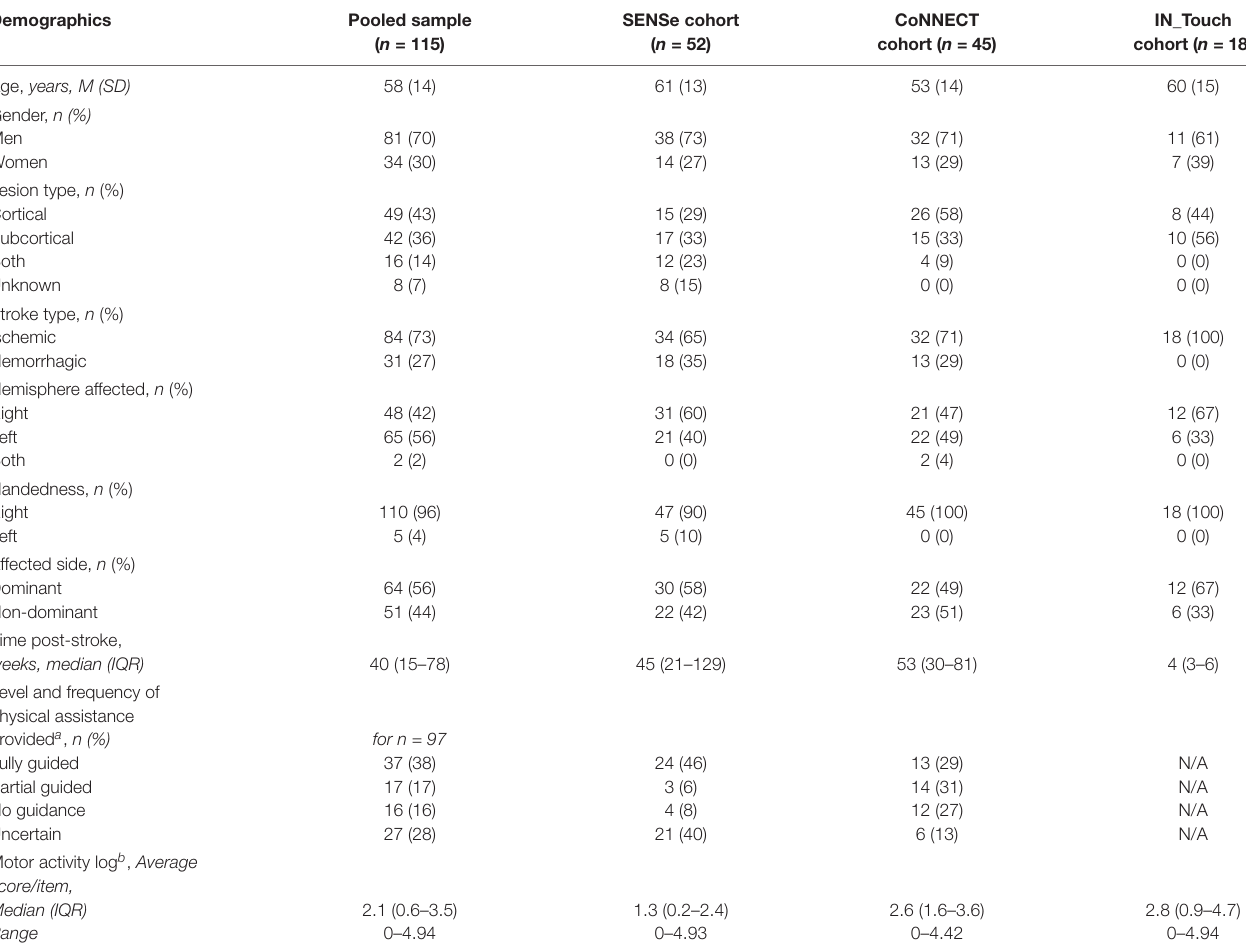
TABLE 3 | Demographic and clinical characteristics of pooled stroke